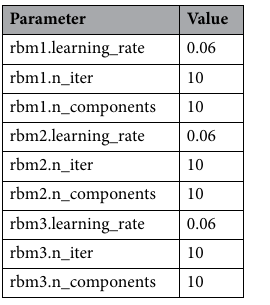
Table 2. Details of the hyper-parameters of the DBM.